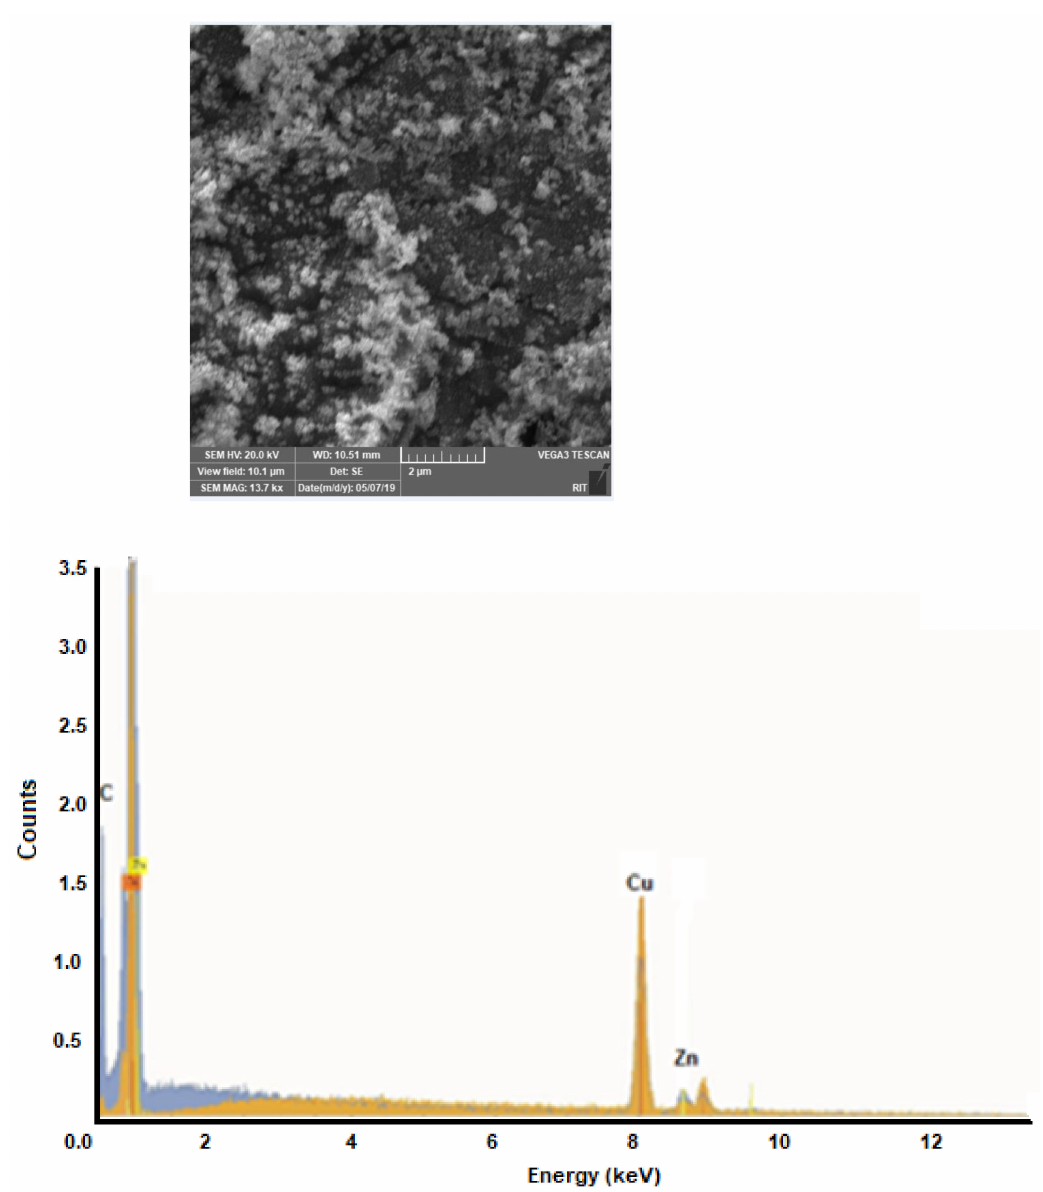
Figure 6. ( Upper picture) SEM of the composite alloy; ( lower picture) the EDX of the